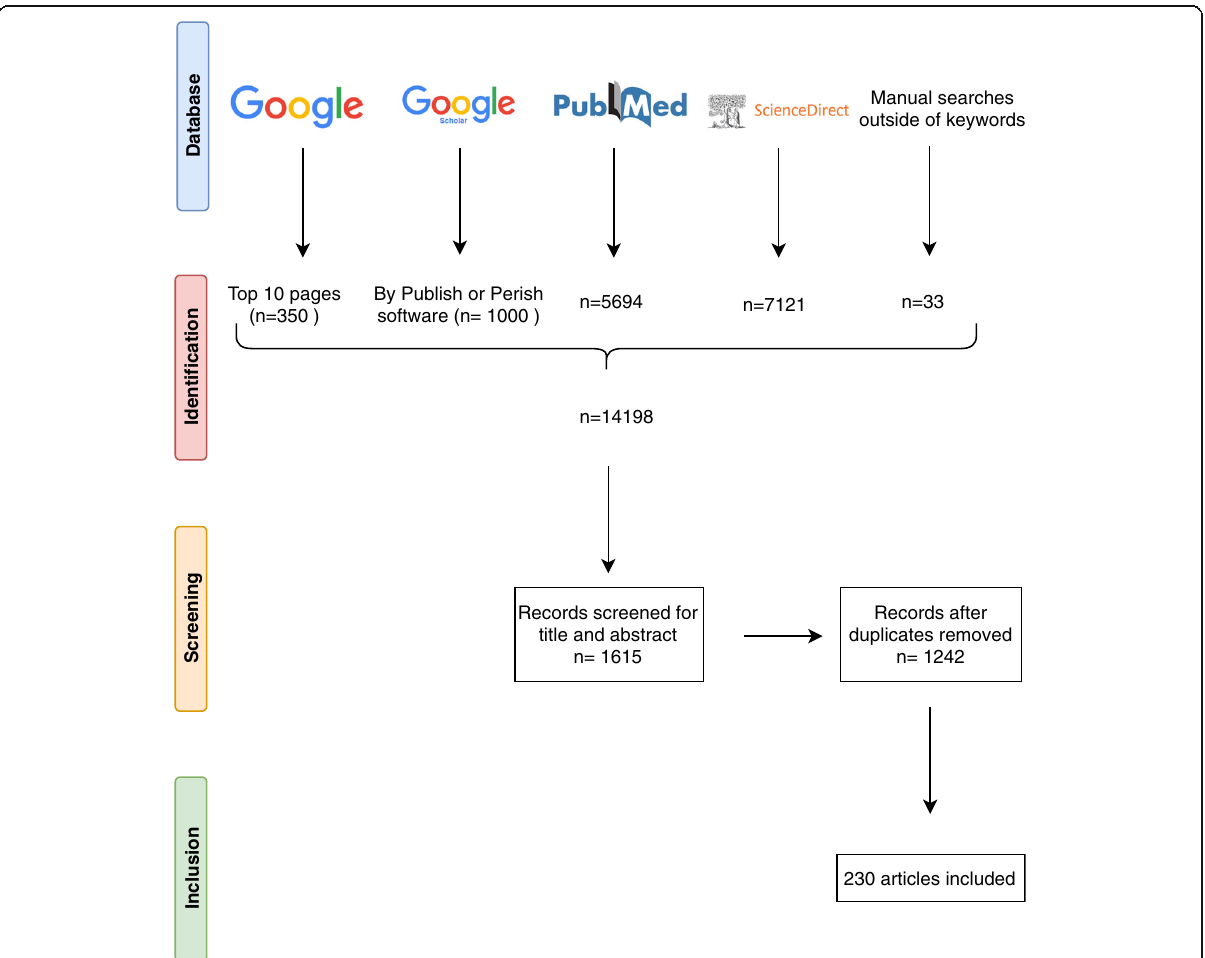
Fig. 1 Summary of the process in a flow